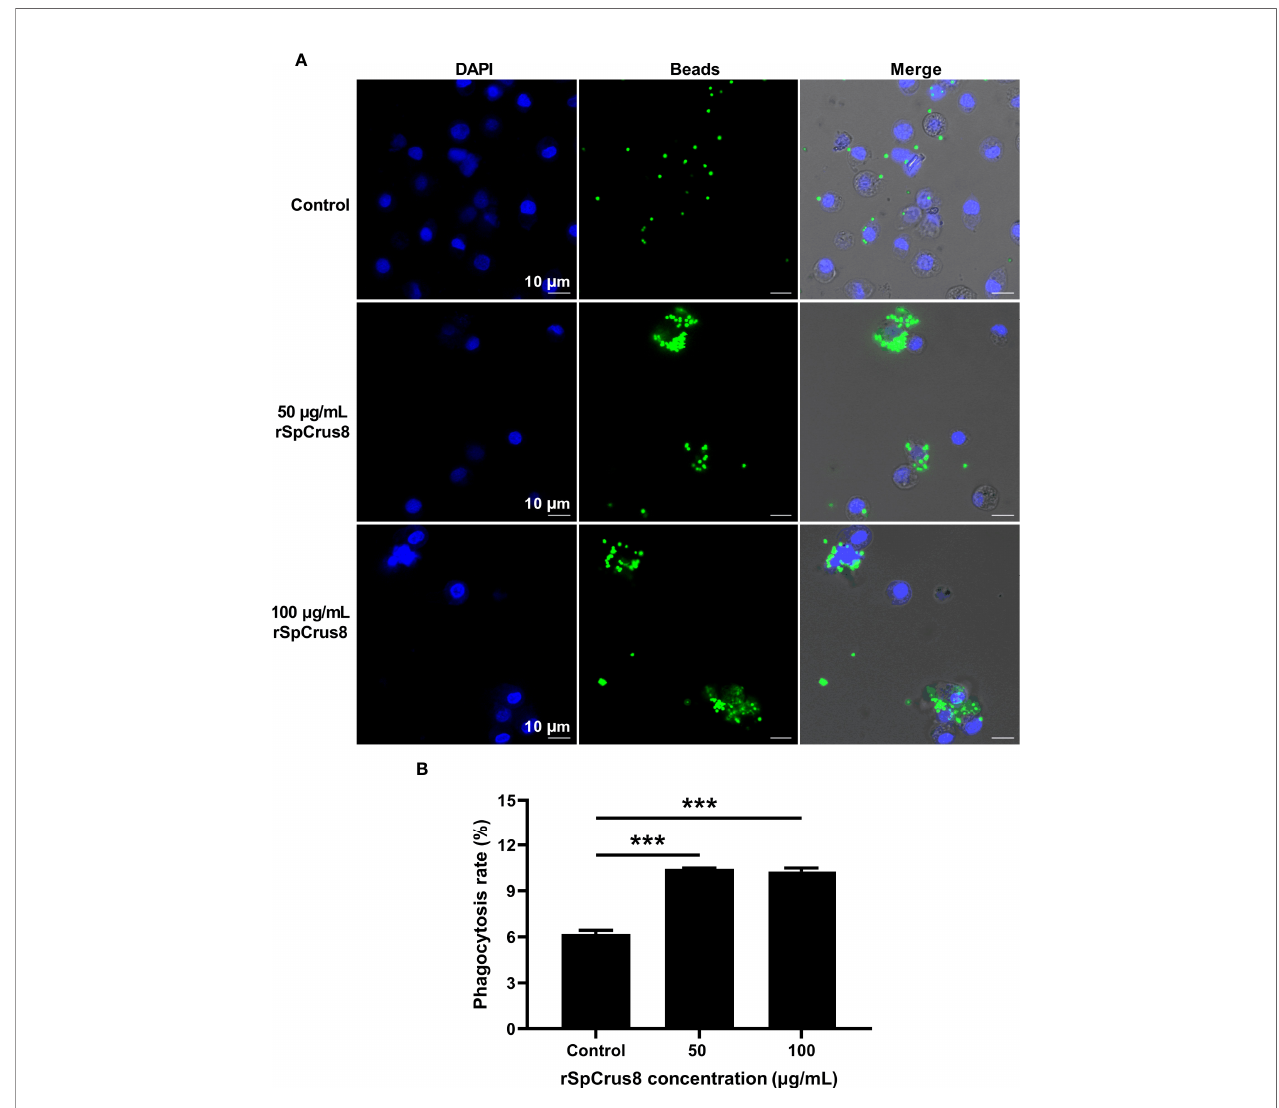
FIGURE 4 | Phagocytosis of fl uorescent microspheres by hemocytes after rSpCrus8 treatment. (A) Phagocytosis of fl uorescent microspheres by hemocytes after rSpCrus8 treatment (50 µg/mL or 100 µg/mL) was observed under CLSM, and equal volumn of L-15 medium was used as control. The nuclei of hemocytes were stained with 4,6-diamino-2-phenyl-indole (DAPI) (blue), and green fl uorescence represented fl uorescent microspheres. (B) The phagocytosis rate of fl uorescent microspheres by hemocytes was determined by fl ow cytometry. Signi fi cant difference was indicated with asterisks, ***p <